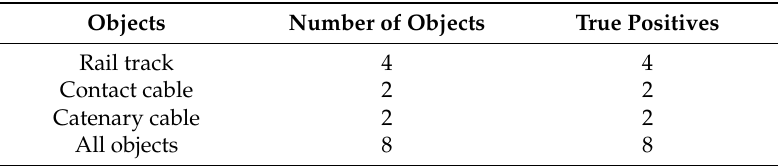
Table 2. The Classification Results at the Object Level.